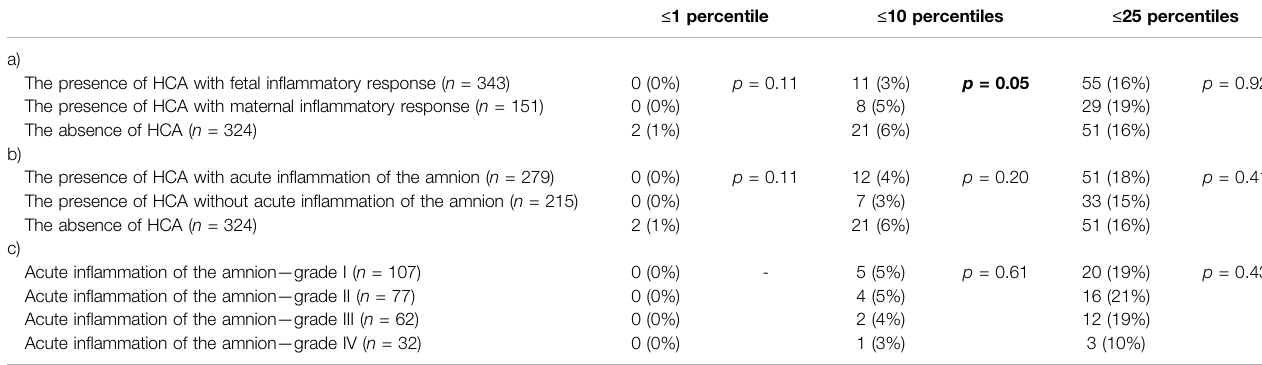
TABLE 5| Therateofnewbornswithbirthweights,expressed aspercentilesderivedfrom thebirthweight standards, thatwereless than orequaltothe fi rst, 10th,and 25th percentiles according to: (a) the presence of HCA with fetal and maternal in fl ammatory responses and the absence of HCA; (b) the presence of HCA with and without acute in fl ammation of the amnion and the absence of HCA; and (c) severity of acute in fl ammation of the amnion (grades I –